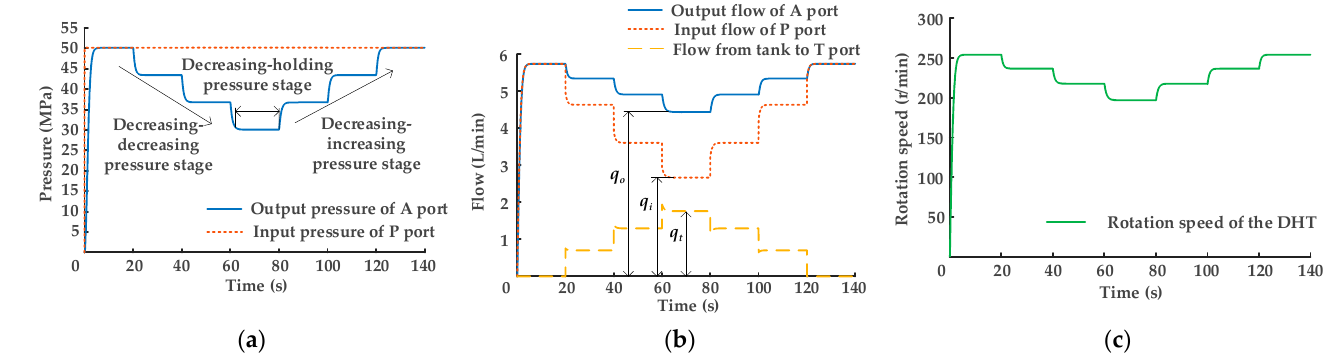
Figure 7. Regulation characteristic curves of DHT in the decreasing pressure stage: ( a ) pressure regulation; ( b ) flow regulation; ( c ) gear–pump/motor unit rotational speed characteristic curves.